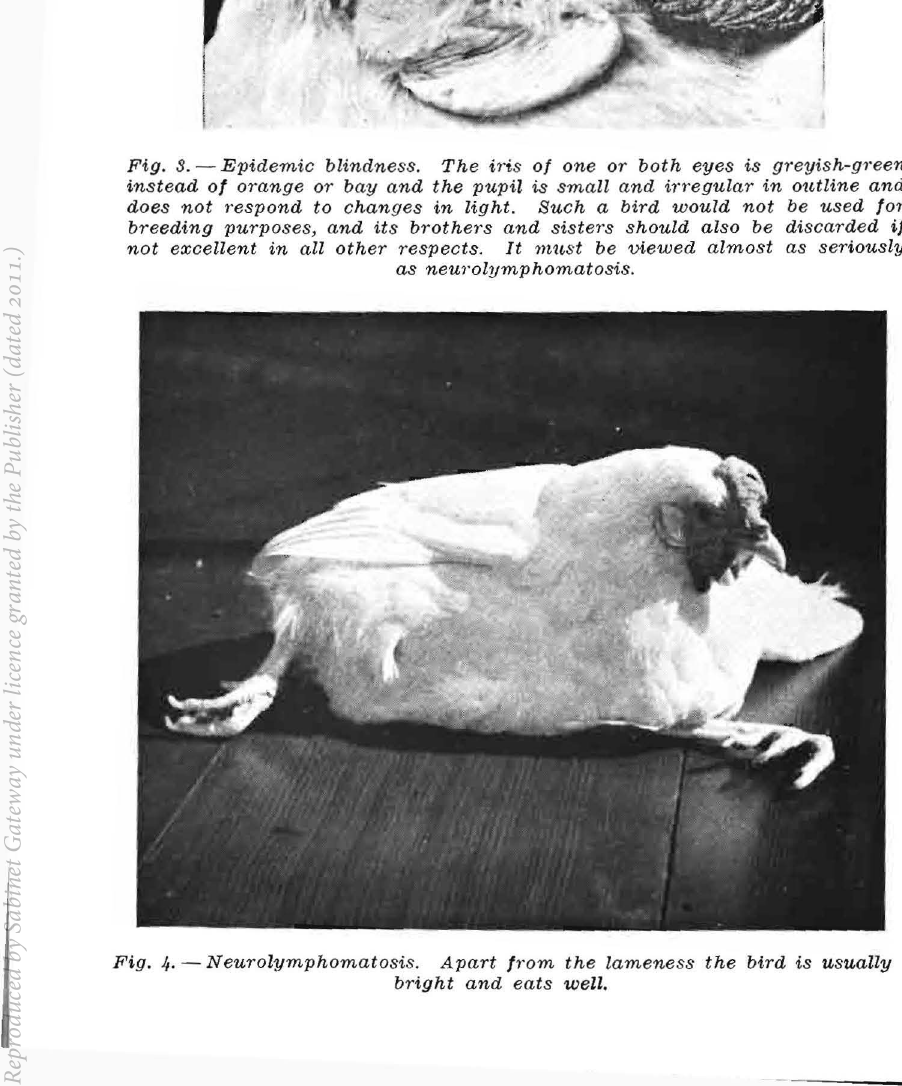
Fig. 4. - Neurolymphomatosis. Apart fl'om the lameness the bird is usually bTight and eats